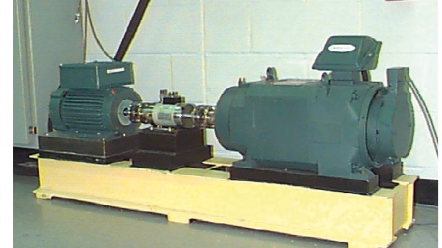
Figure 5: Bearing test stand used for the